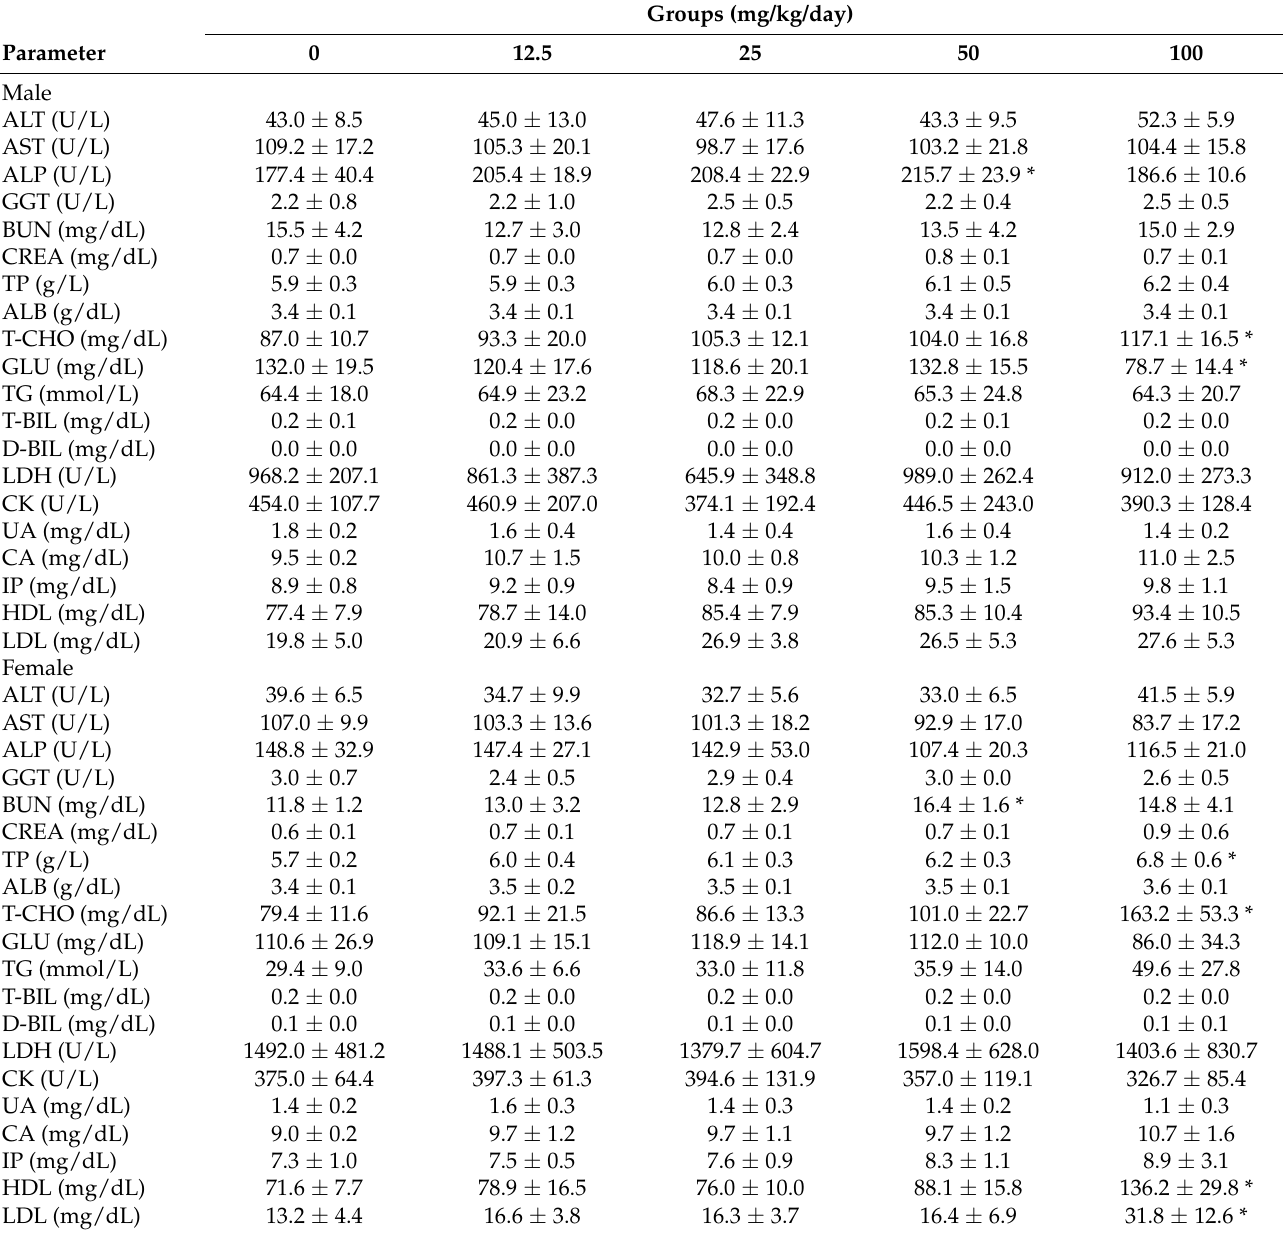
Table 7. Clinical biochemistry after the 28-day repeated oral toxicity